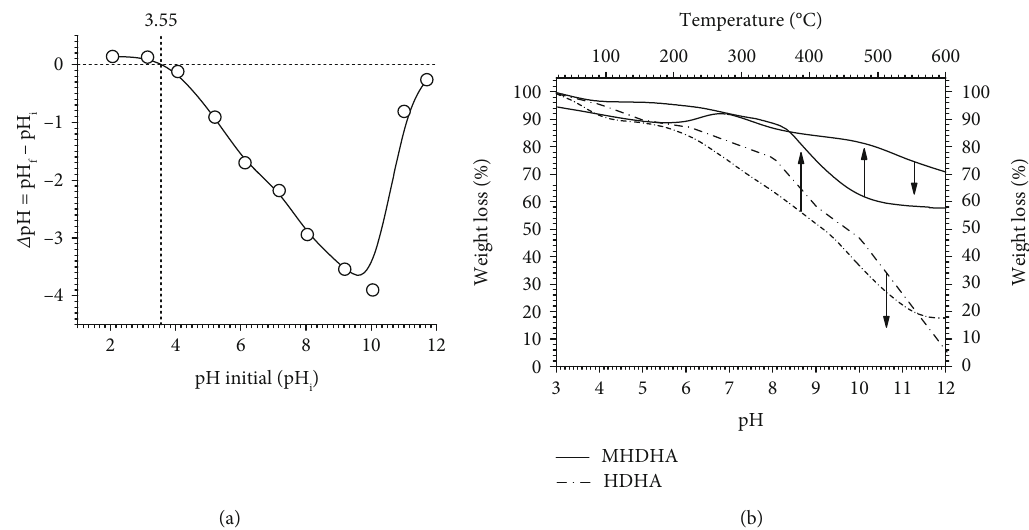
Figure 3: (a) Determination of the point of zero charge ( pH comparison of the medium pH and temperatures on the stability of HDHA and